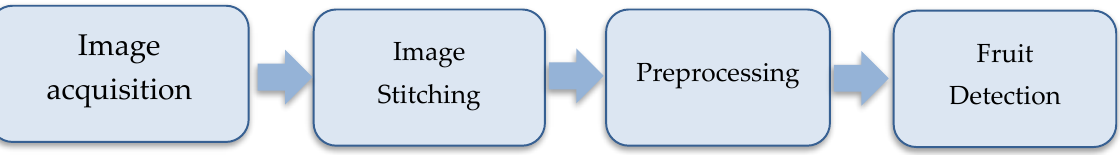
Figure 5. Proposed kiwifruit detection pipeline.